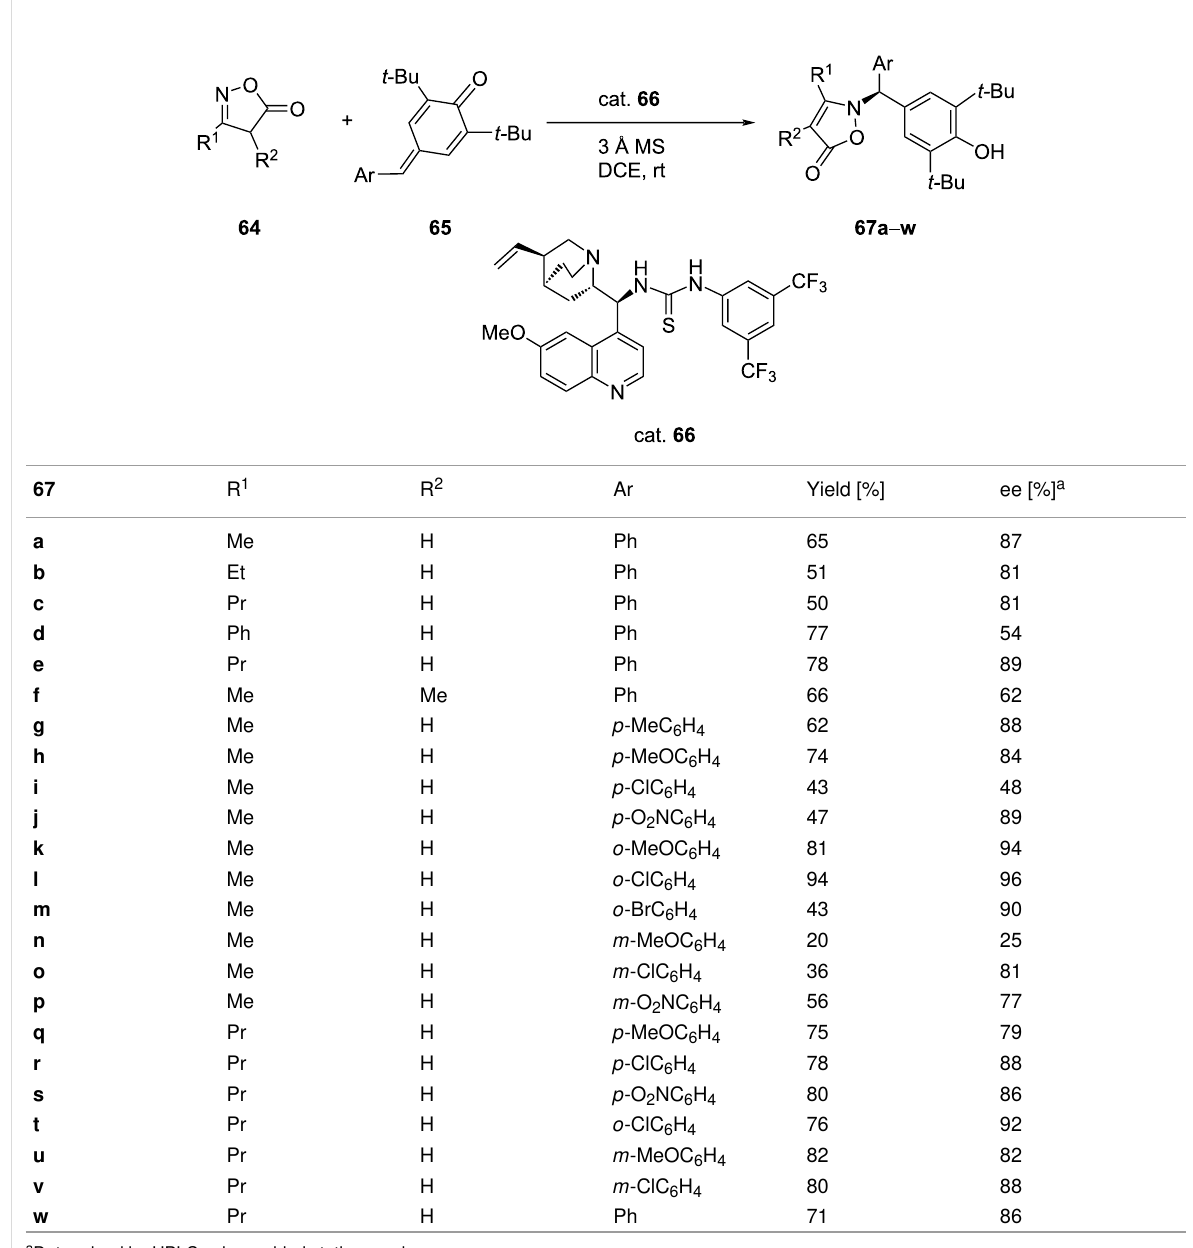
Table 15: Enantioselective 1,6-aza-Michael addition of isoxazolin-5-ones to p- quinone